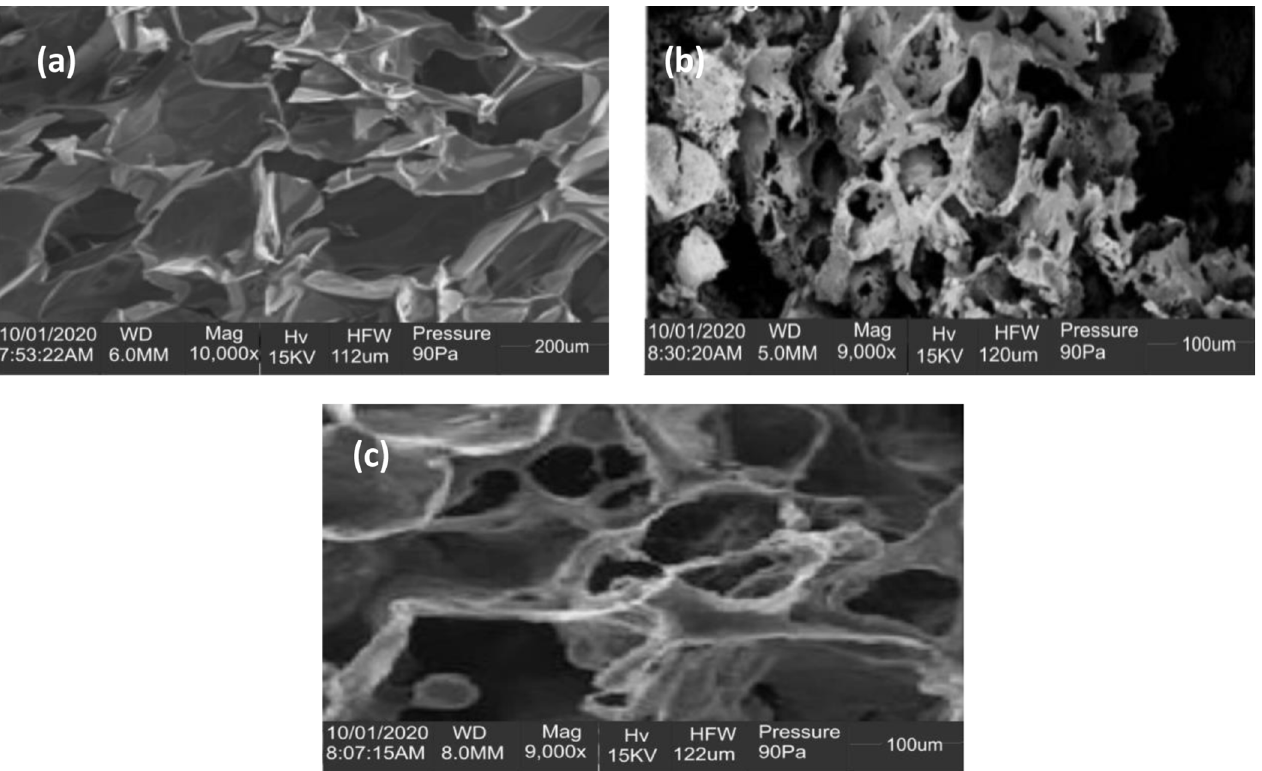
Fig. 1. SEM micrographs of samples (a) un fi lled polyurethane foam (b) dolomite fi lled polyurethane foam (c) kaolin fi lled polyurethane foam.